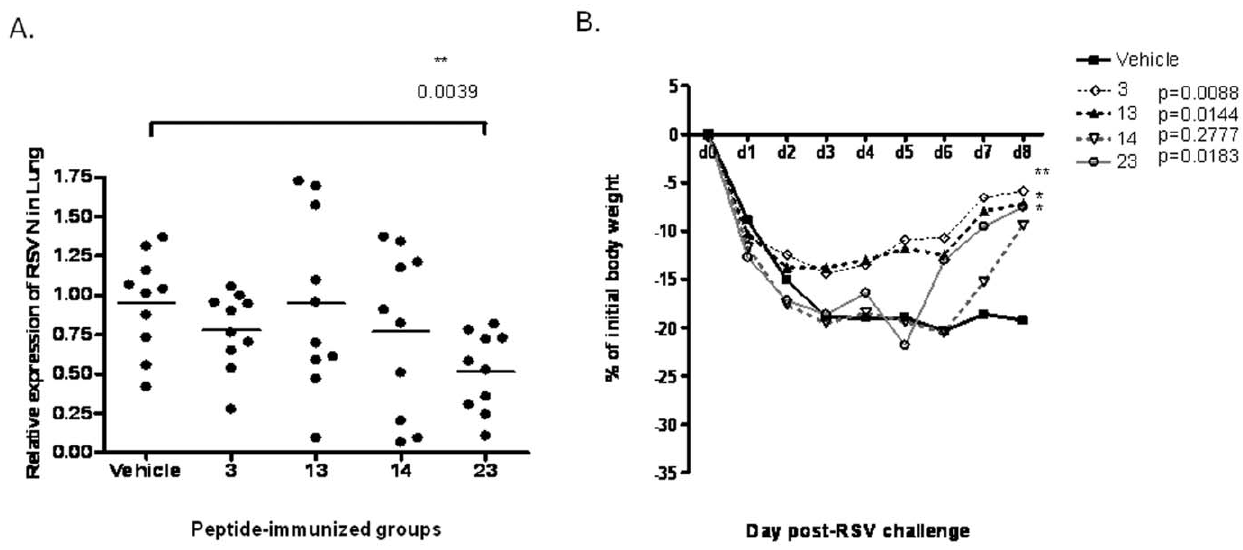
Figure 3. Determination of lung viral load and gain of lost body weight. Mice were immunized twice intranasally with vehicle ( & ), peptide 3 ( e ), peptide 13 ( m ),peptide 14 ( h ), or peptide 23 ( % ) before being intranasally challenged with 10 7 pfu of live RSV B1. (A) The viral load in the lungs of individual mice was determined 4 days after challenge by real-time RT-PCR to quantitate RSV N gene expression as described in the Materials and Methods. 10 mice per group were used and the results are expressed as the relative expression of N gene normalized to GAPDH gene expression for each mouse. *(p , 0.05) indicates they are significantly different from the vehicle-immunized group. (B) The body weight of each mouse was recorded daily for 9 days after virus challenge. Results are expressed as % (mean) for 5 mice in each experimental group. Two independent experiments were performed and data from one is shown. P value , 0.05 calculated for peptide 3, peptide 13, peptide 14, and peptide 23 indicates they are significantly different compared to vehicle-immunized